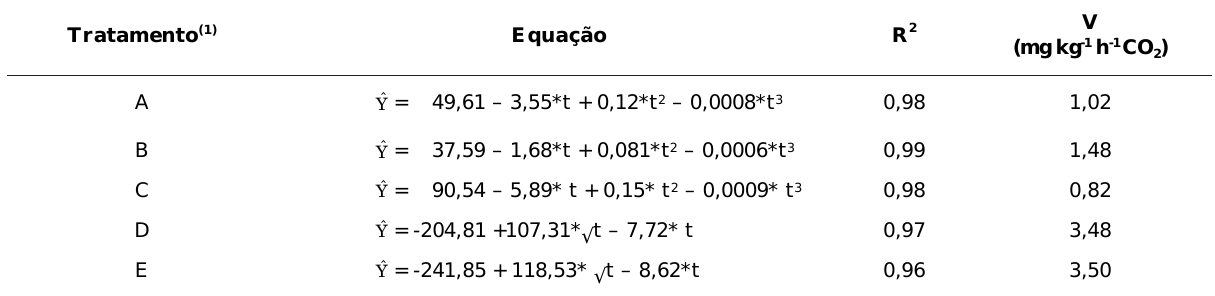
(1) A = solo sem vegetação; B = solo revegetado com leguminosas; C = solo revegetado com gramínea; D = solo sob pastagem natural e E = solo sob floresta. * significativo a 1%.